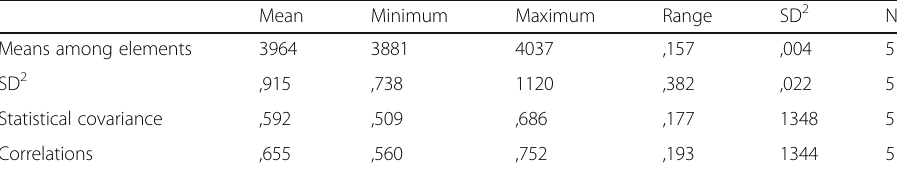
Table 11 Statistics among elements Mean Minimum Maximum Range SD 2 N Means among elements 3964 3881 4037 ,157 ,004 5 SD 2 ,915 ,738 1120 ,382 ,022 5 Statistical covariance ,592 ,509 ,686 ,177 1348 5 Correlations ,655 ,560 ,752 ,193 1344 5 Source: Own development by